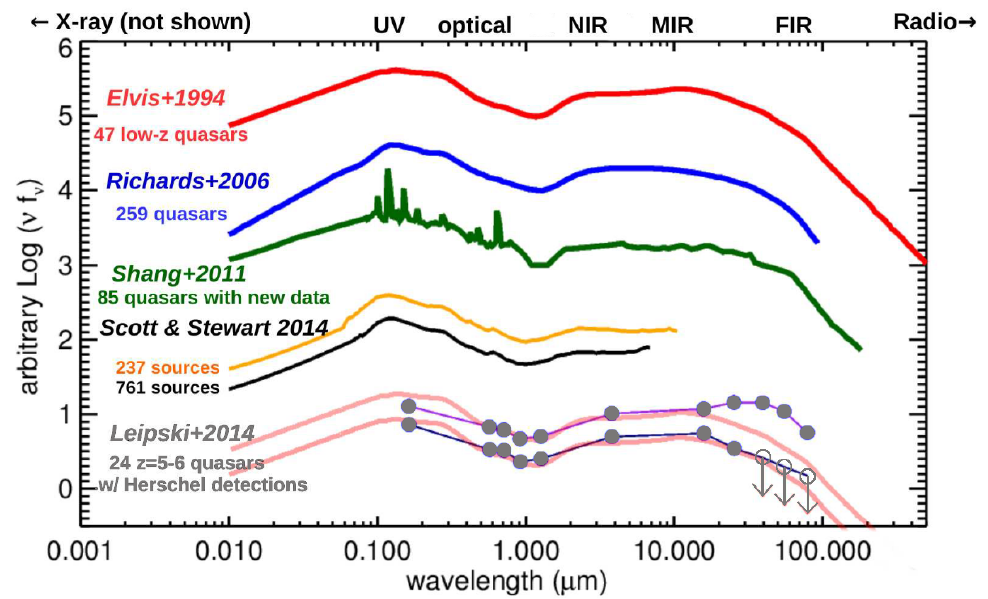
Figure 3. ComparisonofempiricalaverageSEDtemplatesderivedforType1 quasarsfromElvis et al. [32], Richards et al. [33], Shang et al. [35], and Scott & Stewart [34], as well as the averaged SEDs of z ∼ 5–6.5 quasars with Herschel detections from Leipski et al.